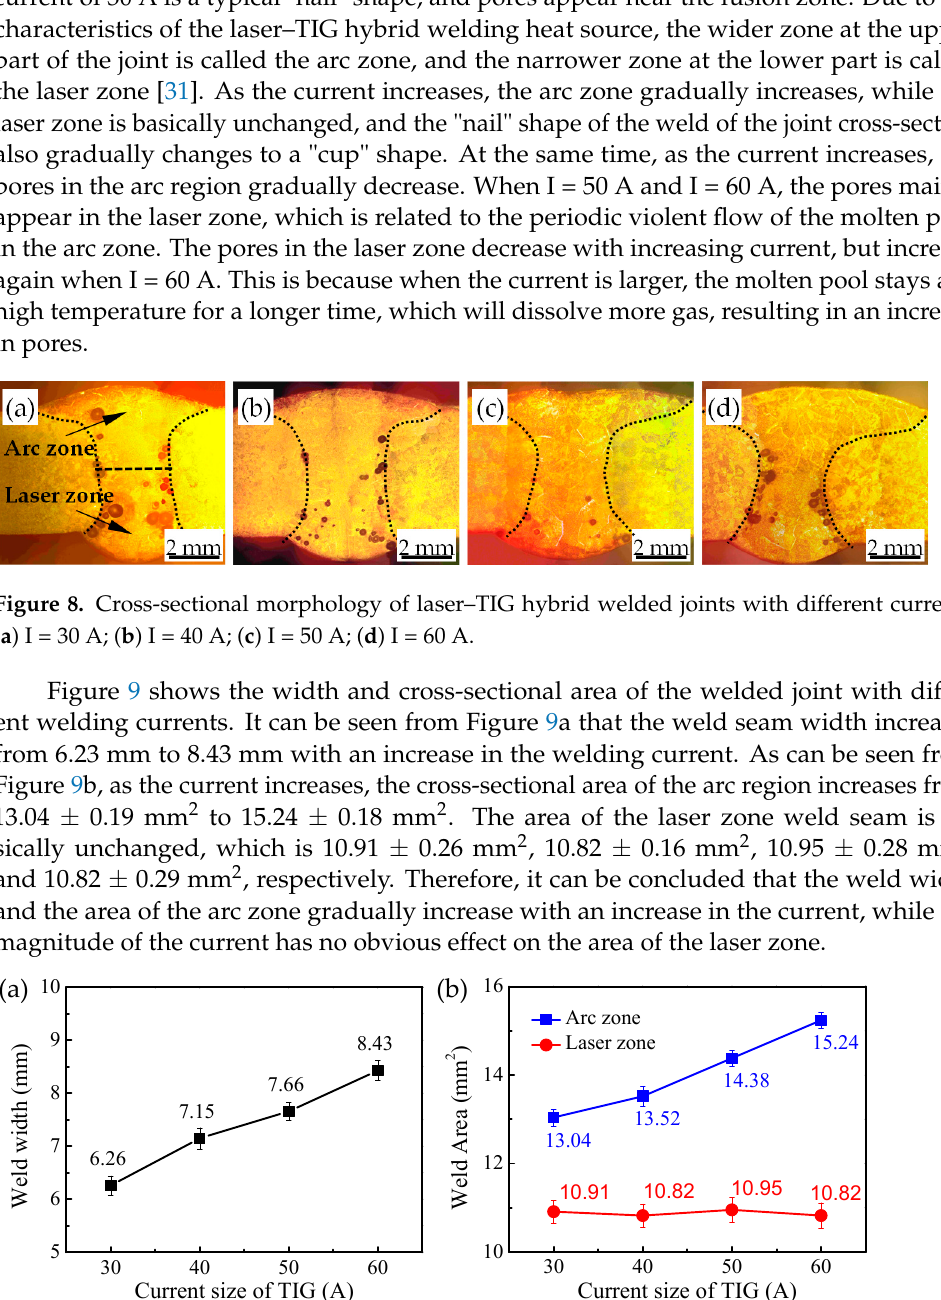
ms; ( c ) t = 3 ms; ( d ) t = 4 ms.